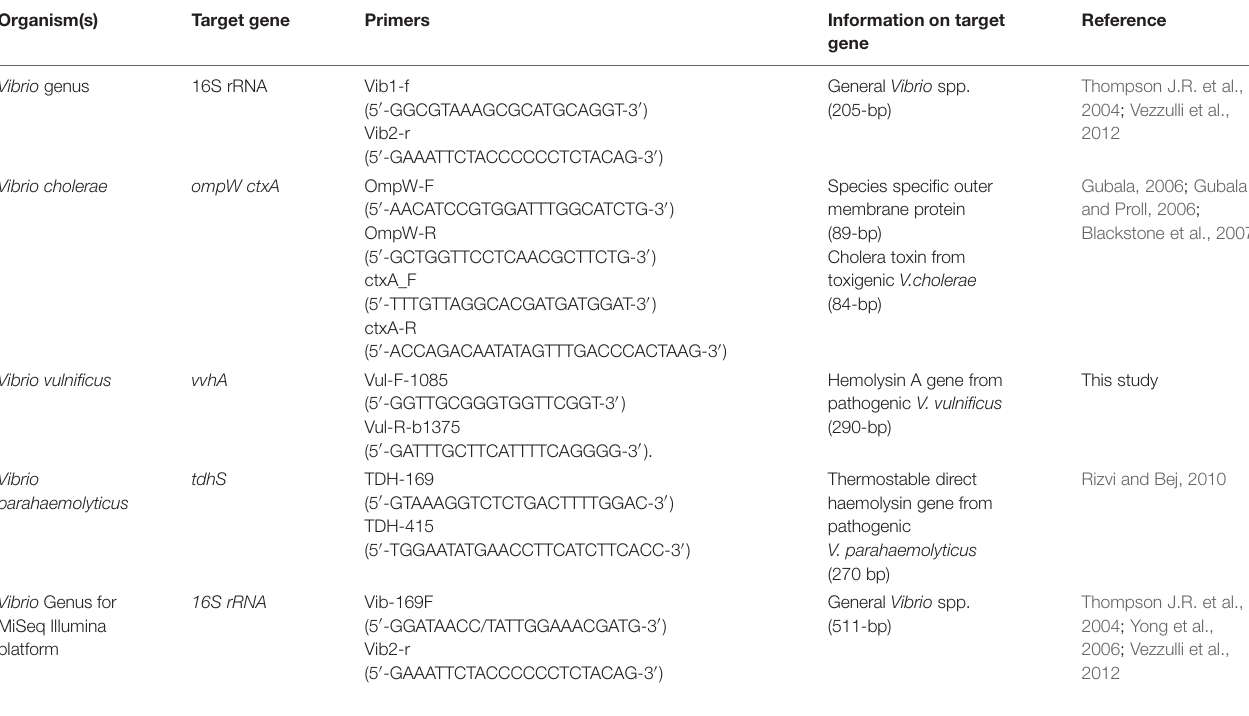
TABLE 1 | Primers for Q-PCR detection of Vibrio species and for next generation sequencing.